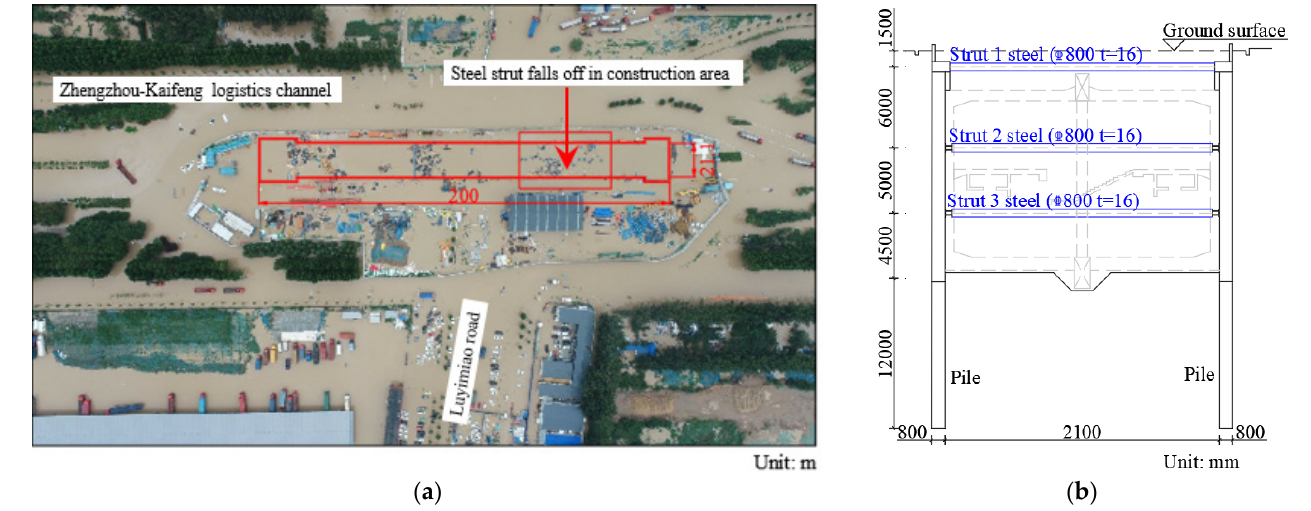
Figure 1. Design and construction overview of Xiaonangang Station. ( a ) The construction schedule; ( b ) cross sectional drawing.